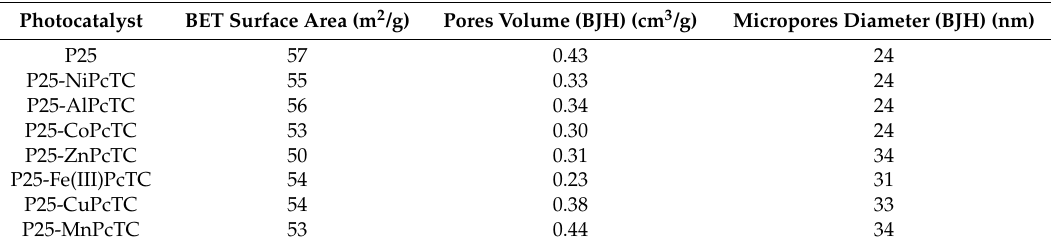
Table 3. Textural properties of the